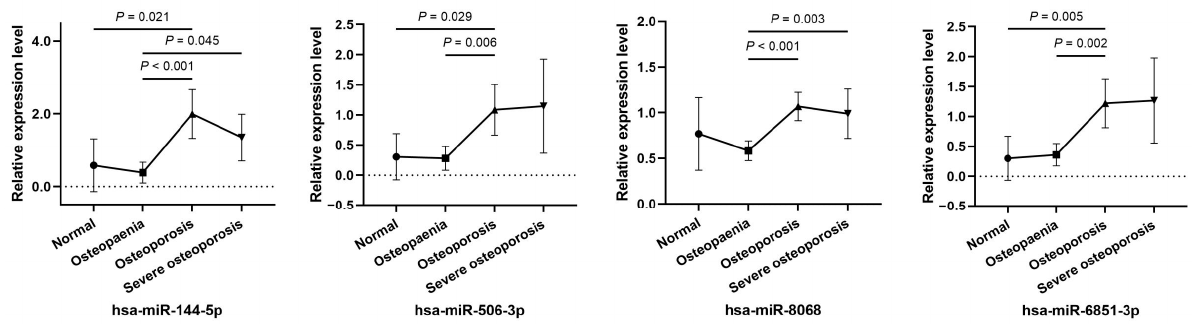
Figure 4. Comparison of the relative expression levels of key miRNAs among the 4